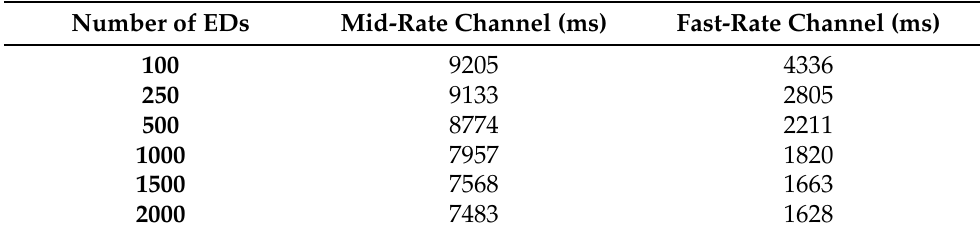
Table 4. Channel times for a single GW scenario, per cycle.